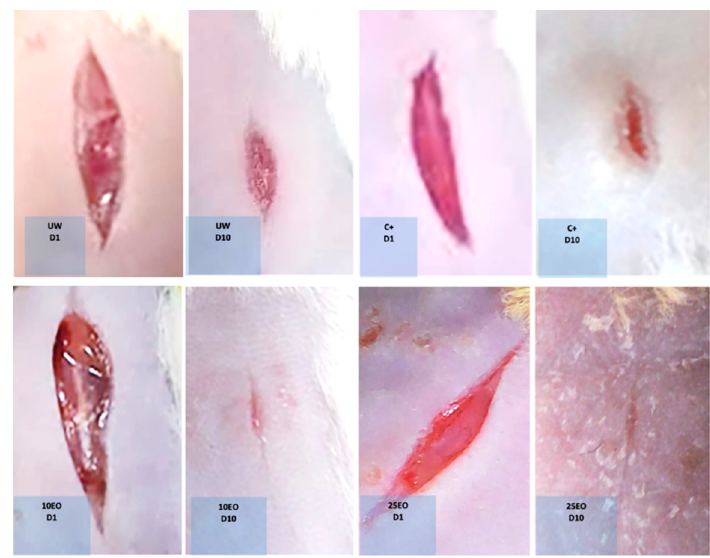
Figure 4. Macroscopic examination of wounds on the first and tenth day of the experiment. UW, untreated wound. C + , positive control—Recoveron NC. 10EO, 10% essential oil. 25EO, 25% essential oil.